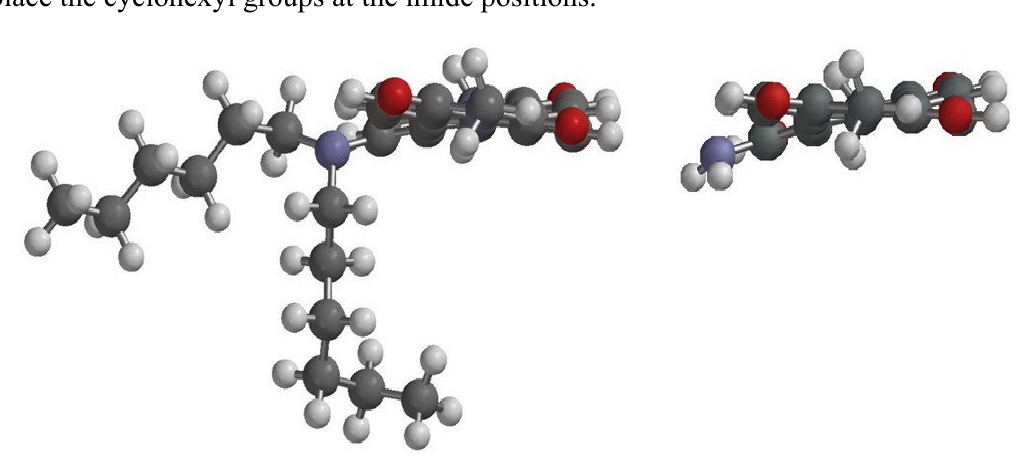
Figure 7. DFT (B3LYP/6-31G**) geometry-optimized structures of 1a ( left ) and 2 ( right ) shown with the view along the long axis. For computational purposes, methyl groups replace the cyclohexyl groups at the imide positions.